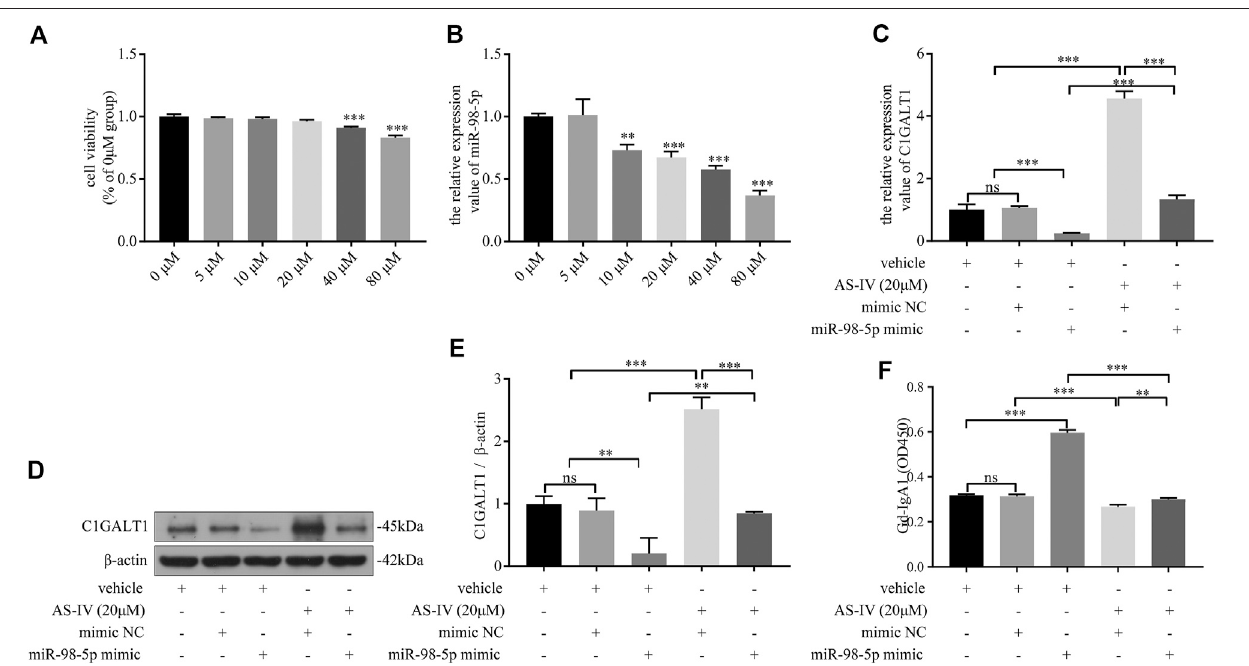
FIGURE 6 | AS-IV downregulated Gd-IgA1 levels via miR-98-5p in DAKIKI cells. (A) Different concentrations of AS-IV toxicity were determined by CCK-8 assay. The cellviability(ofthepercentageof0 μ Min) in5,10,20,40and 80 μ Mgroups were0.99 ± 0.01,0.98 ± 0.01, 0.96 ± 0.01,0.91 ± 0.01, 0.83 ± 0.1. (B) Theexpression levels of miR-98-5p were analyzed by qRT-PCR in DAKIKI cells treated with different concentrations of AS-IV. The relative expression level of miR-98-5p in the 0, 5, 10, 20,40and80 μ Mgroupswere1.00 ± 0.02,1.01 ± 0.10,0.73 ± 0.04,0.67 ± 0.04,0.58 ± 0.03and0.37 ± 0.03. (C) TheexpressionlevelsofC1GALT1mRNAwere analyzed byqRT-PCR in DAKIKI cells. The relativeexpression levels ofC1GALT1 mRNA in the vehicle, vehicle + mimic NC, vehicle + miR-98-5p, AS-IV + mimic NC and AS-IV +miR-98-5pgroups were 1.01 ± 0.13, 1.06 ± 0.04, 0.24 ± 0.02,4.56 ± 0.20and 1.33 ± 0.10. (D) Theexpression ofC1GALT1protein were analyzed bywestern blottinginDAKIKI cells. (E) Foldchangeswerecalculatedbydetermining theratios oftheC1GALT1/ β -actinbandintensitiesinDAKIKI cells.Thesemiquantitative relative level of C1GALT1 protein in the vehicle, vehicle + mimic NC, vehicle + miR-98-5p, AS-IV + mimic NC and AS-IV + miR-98-5p groups were 1.00 ± 0.10, 0.89 ± 0.16, 0.20 ± 0.20, 2.52 ± 0.15, 0.85 ± 0.02, and 0.37 ± 0.03. (F) The relative levels of Gd-IgA1 were analyzed by VVA in the supernatant of DAKIKI cells. The relative levels of Gd-IgA1 in the vehicle, vehicle + mimic NC, vehicle + miR-98-5p, AS-IV + mimic NC and AS-IV + miR-98-5p groups were 0.32 ± 0.00, 0.31 ± 0.01, 0.60 ± 0.01, 0.27 ± 0.01, and 0.30 ± 0.01. ns, no signi fi cance; ** p < 0.01, *** p < 0.001. Note: AS-IV, Astragaloside IV; Gd-IgA1, galactose-de fi cient IgA1; CCK-8, cell counting kit-8 assay; qRT-PCR, quantitative real-time polymerase chain reaction; C1GALT1, β -1, 3-galactosyltransferase; VVA, Vicia Villosa lectin-binding